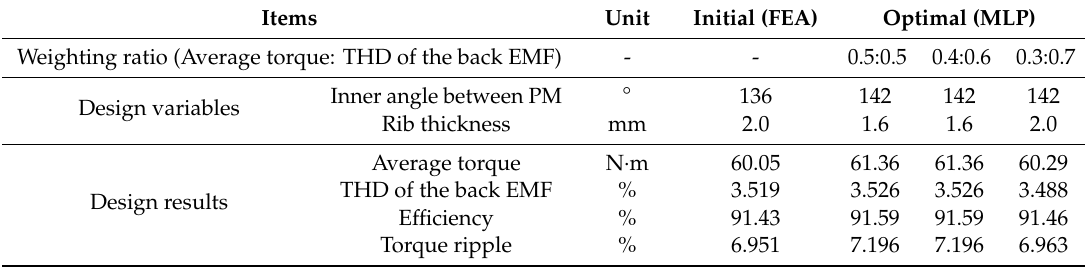
Table 5. Optimization results according to the weighting change.